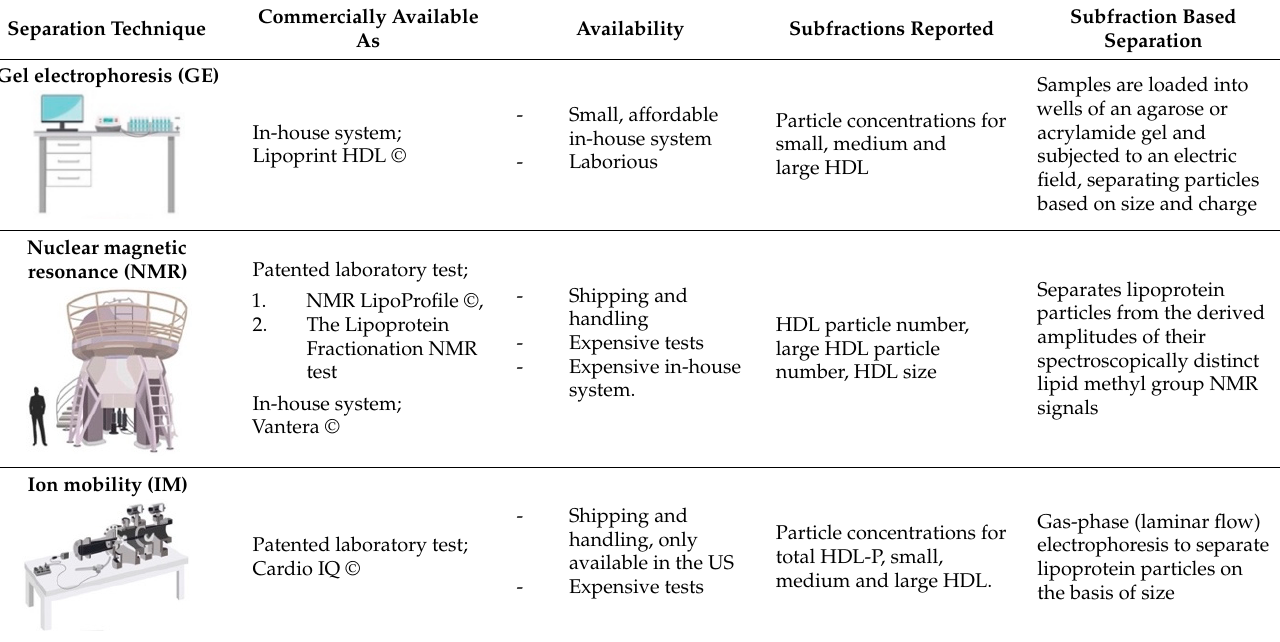
Table 1. Commercially available tests that report HDL subfractions.